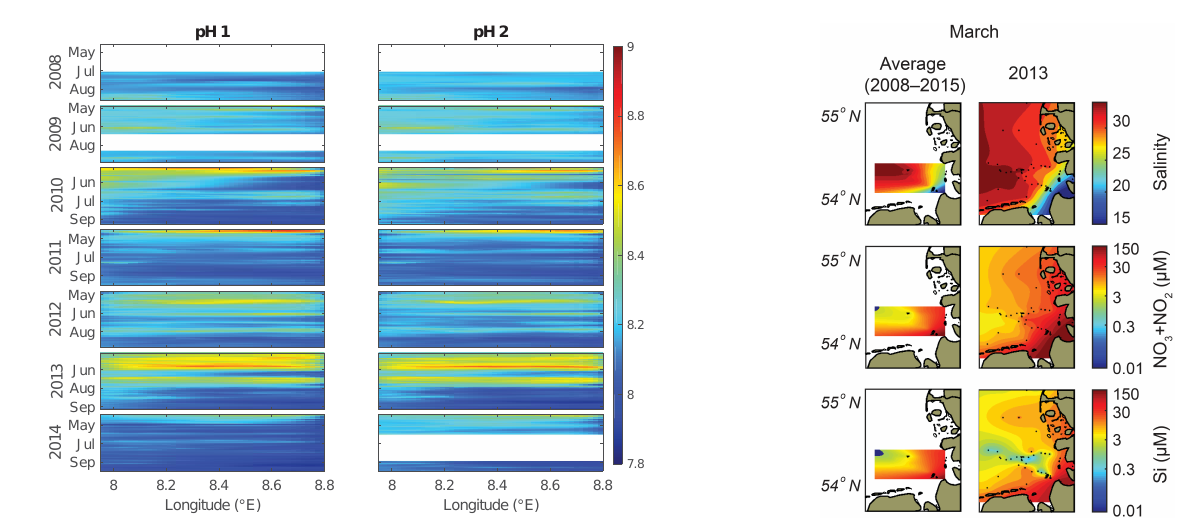
Figure 10. Maps of interpolated (Kriging method of interpolation) salinity, nitrate + nitrite (NO 3 + NO 2 , µM) and silicate (Si, µM) for the month of March. The left panels show average parameter distri- butions in March, based on 7 years of data (2008–2015, excluding 2013) from BAH AWI stations (Table 1); the right panels show in- terpolated parameters from 15 to 27 March 2013, measured at BAH AWI, BSH, FerryBox and HPA stations (Tables 1 and